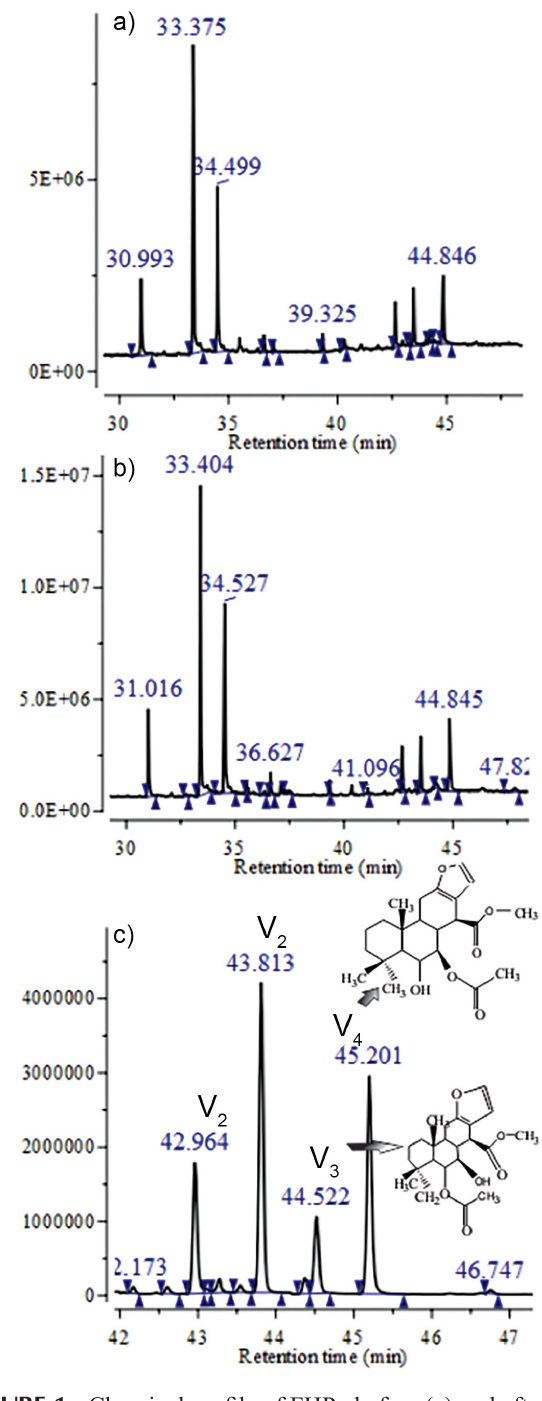
FIGURE 1 - Chemical profile of FHPp before (a) and after (b) the process of microencapsulation (F1-MC, F2-MC, F3-MC) by GC-MS-TIC, and identifying of vouacapans quantified by GC-MS-SIM (c). Compounds with a retention time between 30 and 37 min, are derived from the geranylgeraniol. Compounds with a retention time between 39 and 45 min, correspond to vouacapans. V1 and V2 = not identified; V3 = methyl 6α-acetoxy-7β-hydroxyvouacapan-17β-oate; V4 = methyl